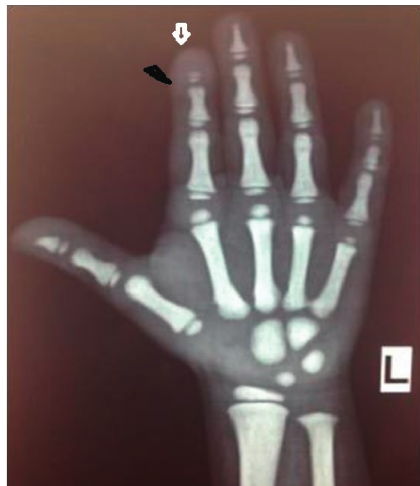
Figure 3: The X-ray of one hand with wrist in case 5-pycnodysostosis patient showing delayed bone age and acroosteolysis in the distal phalanges of thumb and index